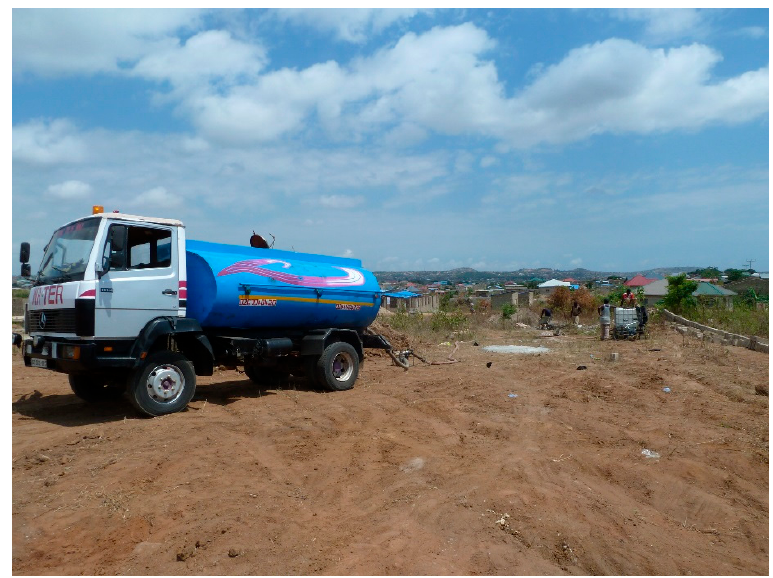
Figure 2. Heavy duty tanker truck delivering water for construction purposes in peri-urban areas of Accra. Source: Authors, October 2015.